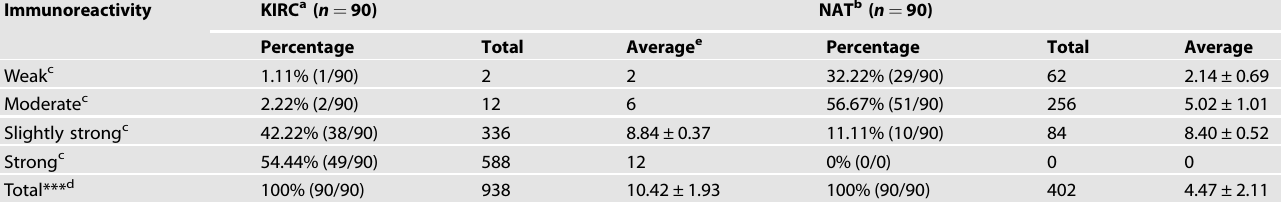
Table 1. Tissue microarray assay of PGK1 expression in kidney renal clear cell carcinoma (No. HKid-CRC180Sur-01, Outdo